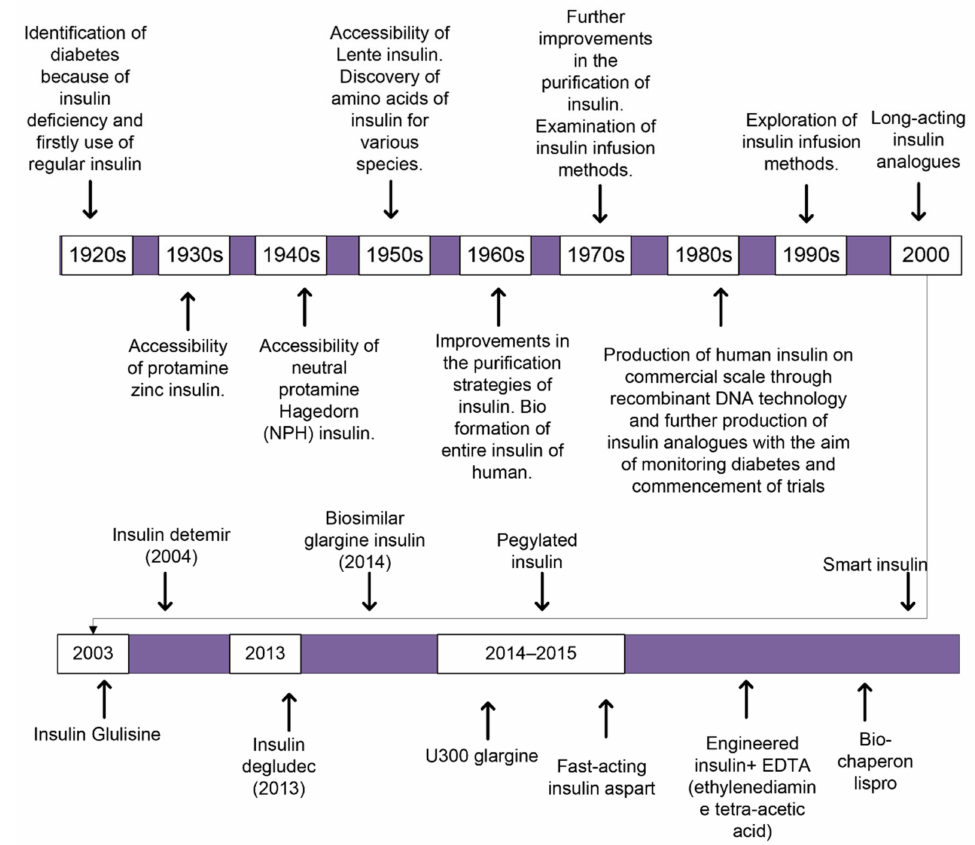
Figure 1. A schematic block-diagram reveals how treatment against diabetes through insulin is improved over time from 1920s up to now. With the introduction of new technologies in the field of biotechnology, how different insulin analogs were discovered and bring improvements in the remediation against diabetes either TIDM or